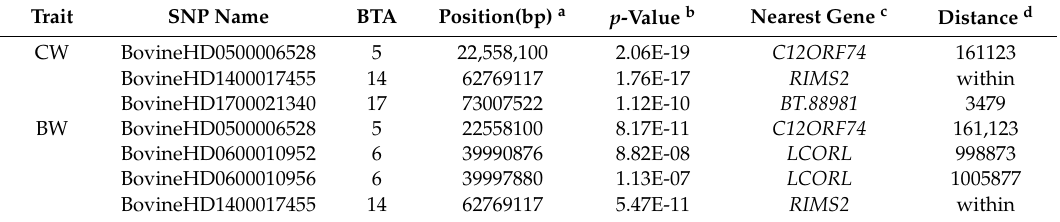
Table 3. Significant SNPs and candidate genes identified by the Fast-EB-LMM method for carcass weight (CW) and bone weight (BW) in the Chinese Simmental beef cattle